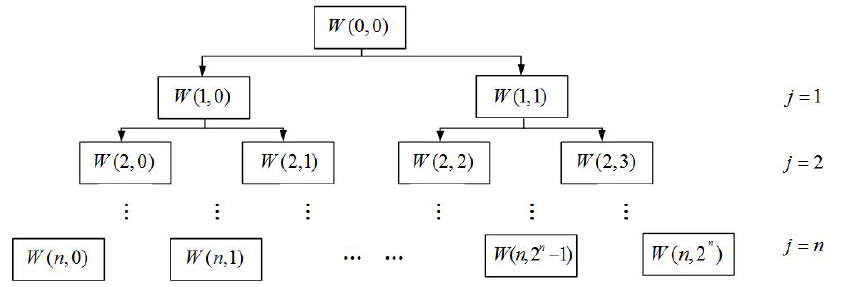
Figure 3. Wavelet decomposition tree.